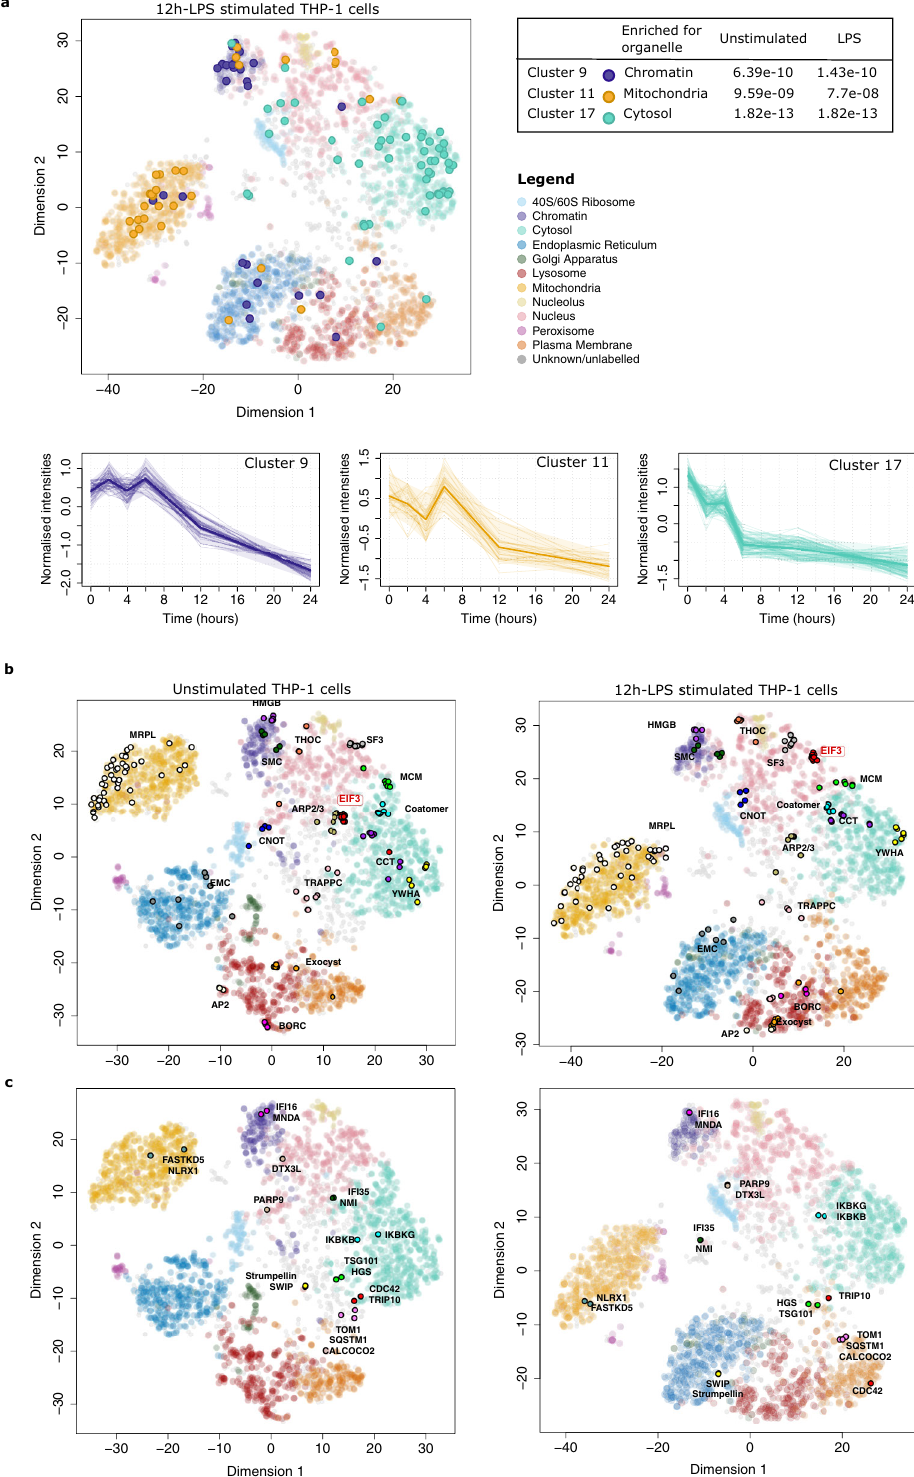
Fig. 7 The hyperLOPIT dataset can be used as a scaffold to overlay additional layers of spatial information. a Three temporal clusters from the Bayesian temporal clustering analysis (cluster numbers 9 (purple), 11 (yellow) and 17 (cyan)) were overlaid onto a t-SNE projection of the hyperLOPIT data. A Fisher ’ s exact test was used to determine that these three clusters were enriched for individual hyperLOPIT organelles ( p -values were adjusted using a Benjamini – Hochberg correction). The temporal pro fi les of the three Bayesian temporal clusters during the 24 h-LPS time-course are also shown. A single bold line on each pro fi le plot shows the mean normalised MDI pro fi le and the 0.05 and 0.95 quantiles of each cluster is highlighted by shaded bands. b Several protein complexes were overlaid onto the hyperLOPIT plot. c Protein – protein interaction partner pairs from the literature were shown to co-localise with each other in hyperLOPIT space. Source data are provided as a Source Data fi